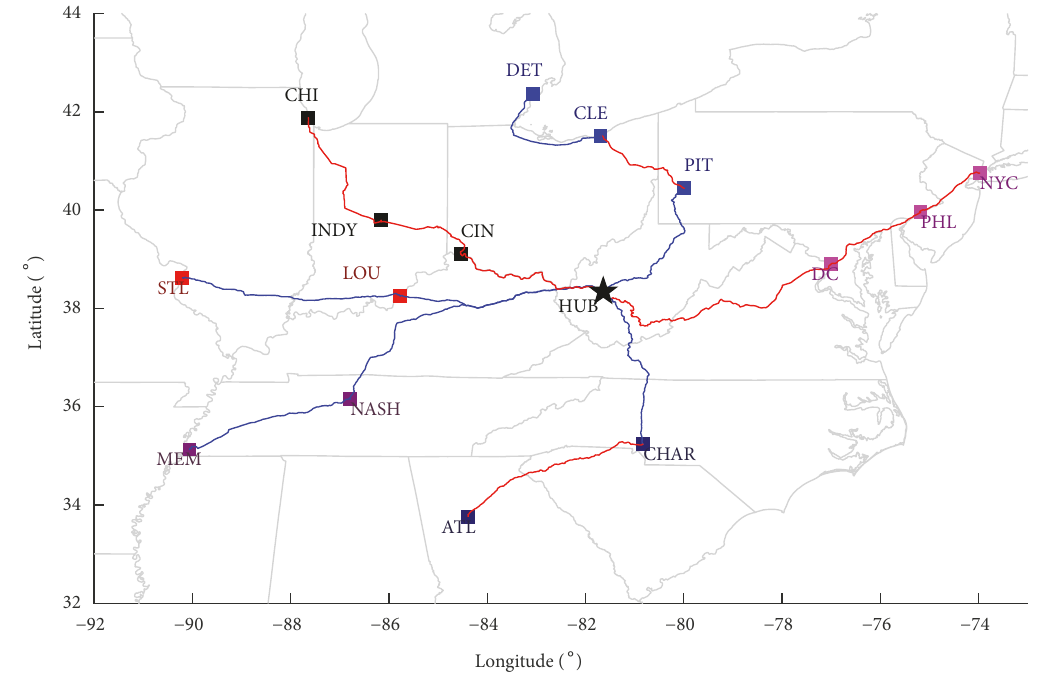
Figure 2: Solution of mass transit system showing mode of transportation: red = train; blue = car. Table 3: Distance of routes and departure and arrival times of the mass transit system.